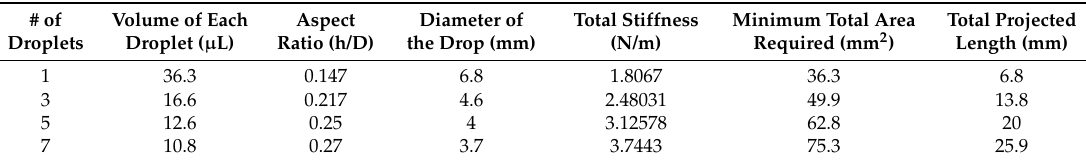
Table 2. Case study of droplet(s) supporting a fixed load at constant gap height, the contact angle is 110 ◦ top and bottom. The total supporting force is 1078 µ N and the gap height is 1